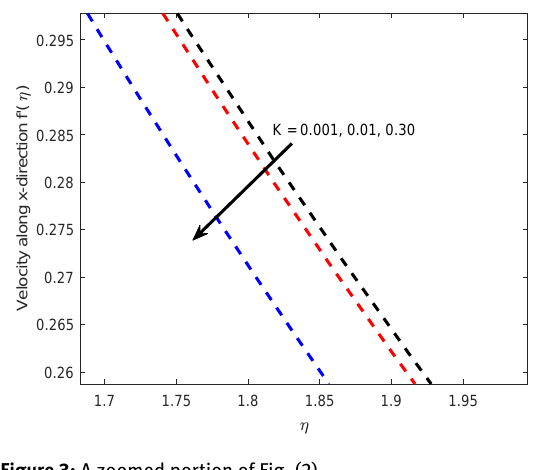
Figure 3: A zoomed portion of Fig.